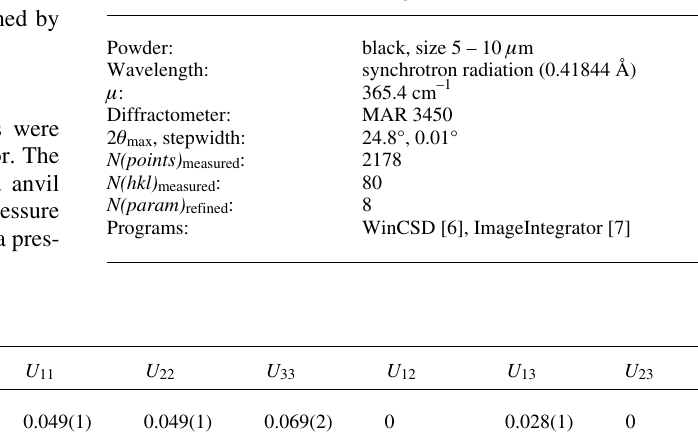
Table 1. Data collection and